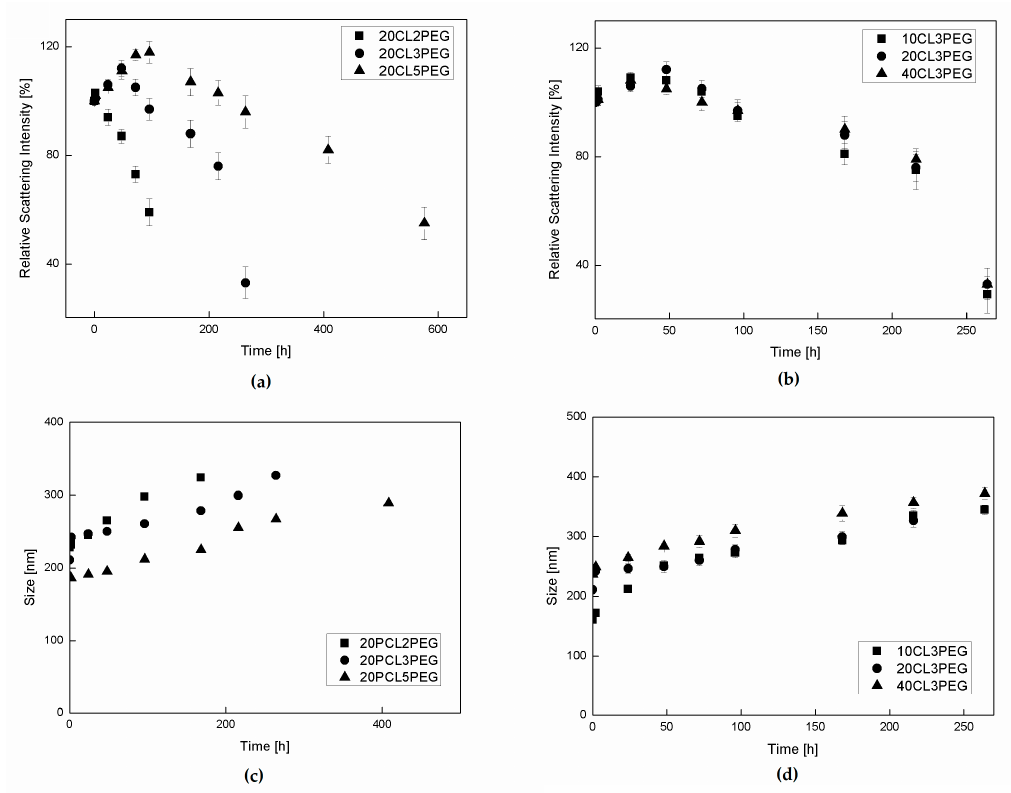
Figure 5. Evolution of relative scattering intensity and NP size of the samples in cellular medium. ( a , c ) Comparison between samples with different number of CL units in the side chains. ( b , d ) Comparison between samples with different DP of the backbone. The values and error bars represent the mean and standard deviation of three replicates.